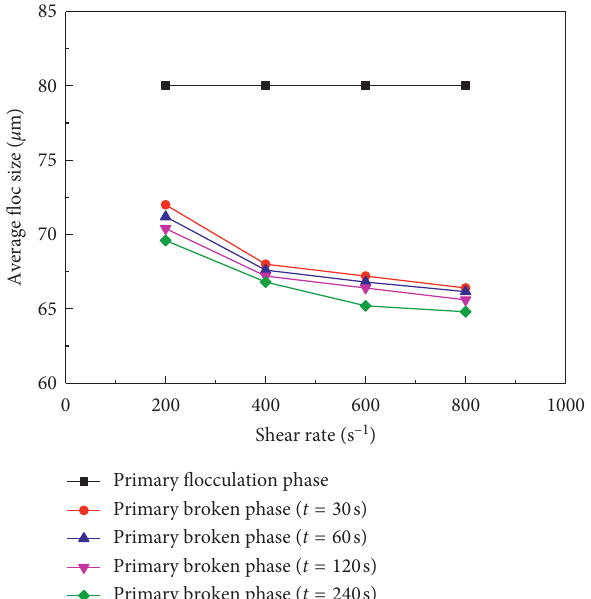
Figure 6: The variation of average floc size with shear rate during different shear times in the primary flocculation and primary broken phases.